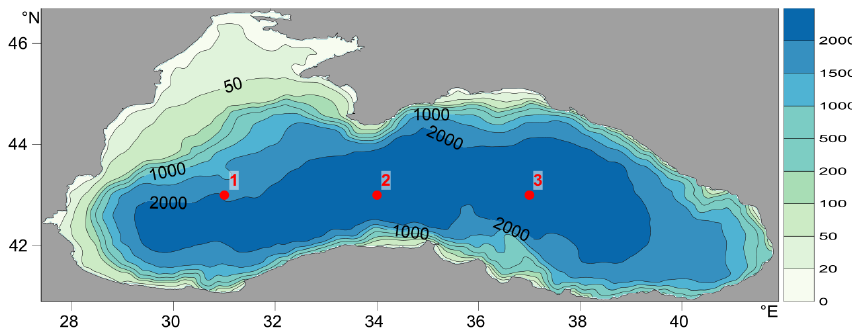
Figure 2. Bathymetry of the study area. Depths are in metres. Red dots indicate validation